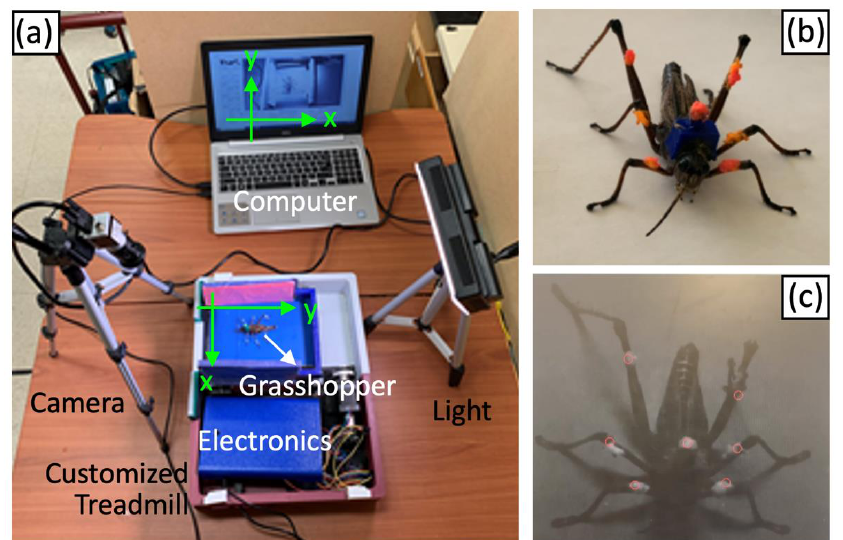
Figure 6. ( a ) Overall experimental setup of the motorized insect treadmill, which is capable of changing belt speed, with optical recording system. ( b ) One of the grasshoppers with the reflective markers (fluorescent pigment powder) and ( c ) the output of the offline Kanade–Lucas–Tomasi (KLT) algorithm using MATLAB. To track the seven reflective markers placed on the grasshopper subject (six for each leg and one for center of body), we utilized a point tracker object from the MATLAB signal